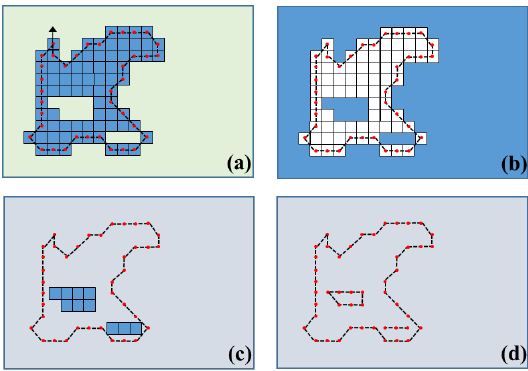
Figure 2. Boundary tracing and hollow objects detected by scheme: ( a ) Boundary tracing; ( b ) Inversion of binary raster image; ( c ) Hollow area detection by labeling; ( d ) Boundary tracing of hollow area (Figure is adopted from [15]).